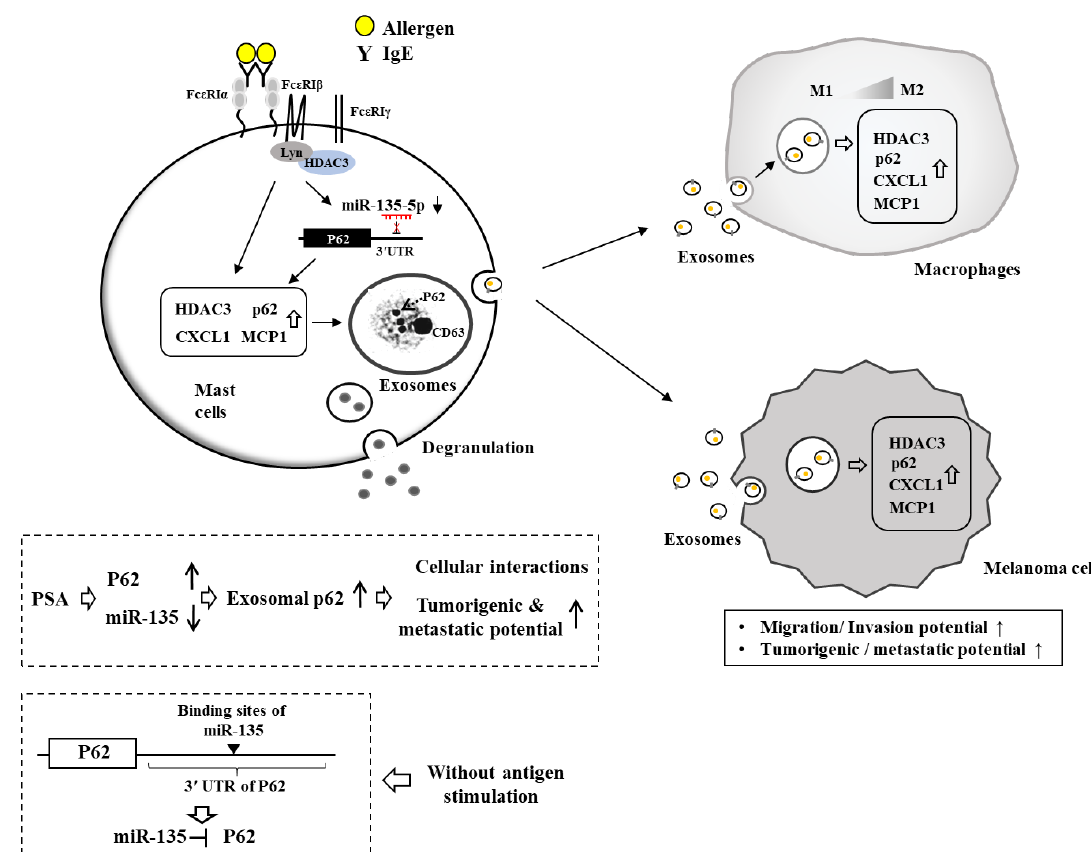
Figure 5. Exosomes mediate cellular interactions during PCA and PSA. Allergen stimulation induces the interaction between FcεRI and HDAC3. The expression of p62, a selective receptor of autophagy, is increased by allergen stimulation. The expression levels of HDAC3 and MCP1 are also increased. P62 binds to the promoter sequences of miR-135-5p to decrease the expression of miR-135-5p. In the absence of allergen stimulation, miR-135-5p binds to the 3 ′ UTR of P62 to decrease the expression of p62. P62 is present in the exosomes of allergen-stimulated mast cells and mediates cellular interactions during PCA and PSA. P62-containig exosomes promote differentiation of M2 macrophages. M2 macrophages, activated by exosomes, display higher expressions of CD163, but a lower expression of iNOS than the M1 macrophages. P62 increases expression levels of HDAC3 and MCP1 in macrophages. P62-containing exosomes also enhance tumorigenic and metastatic potential of melanoma cells. CD63 is a surface marker of exosomes. The presence of p62 within the exosomes was confirmed by immuno-electron microscopy. Arrow indicates p62 in the exosomes. The T-bar arrows denote negative regulation and hollow arrows denote positive regulation. The ↑ arrows denote increased expression level/ increased characteristics and ↓ arrows decreased expression level.